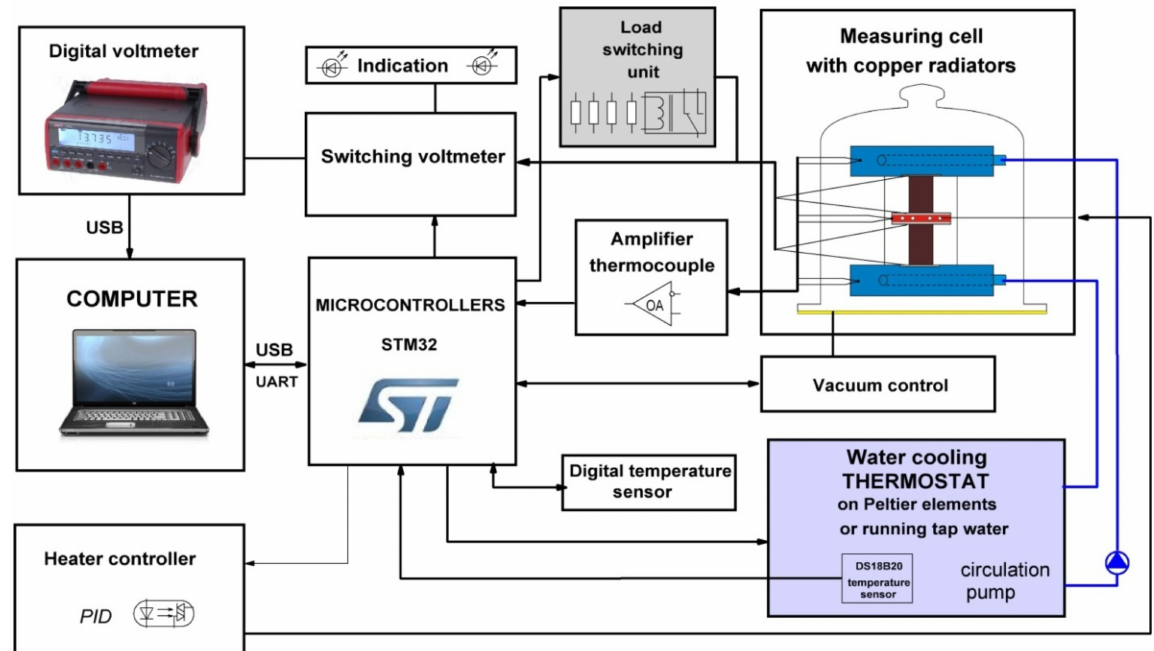
Figure 5. Block diagram of setup for measuring output characteristics. The efficiency of TE unicouple (TE module) is defined as: